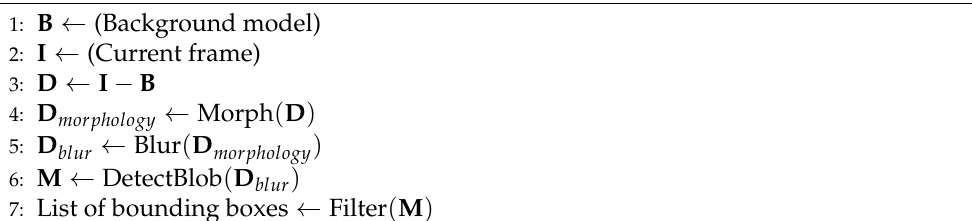
Algorithm 1 Using background subtraction for bird detection and localization in monochrome video